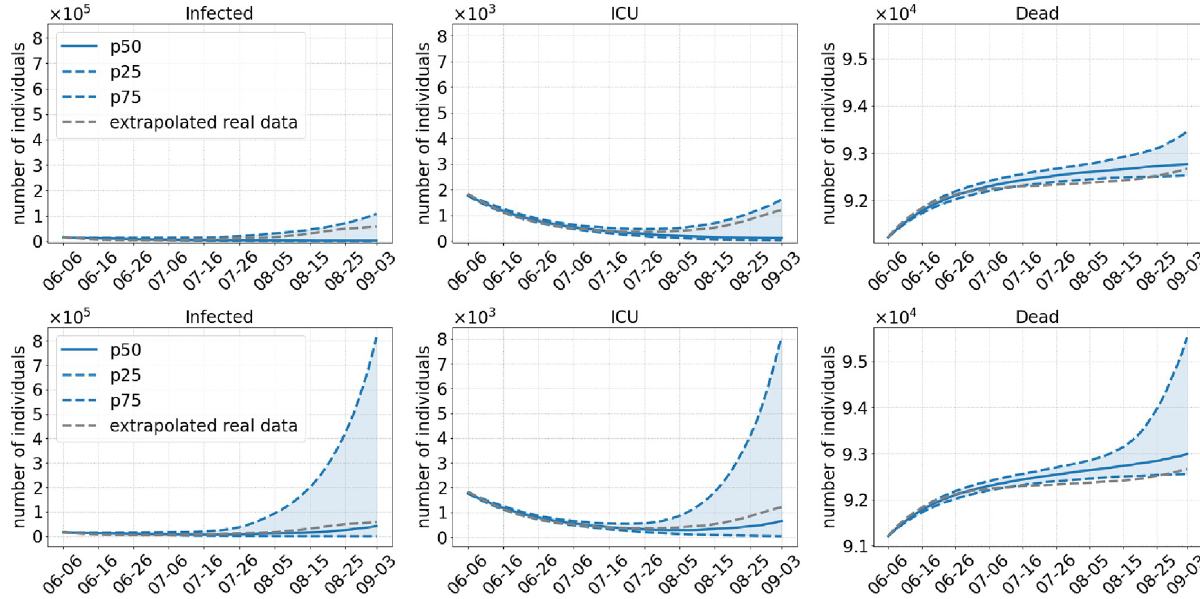
Fig 5. Results of Scenario 2: Commuter testing once a week with local NPIs decreed until July 01, 2021, keeping masks and distancing after opening. The median of 500 runs is shown in solid blue; the blue dotted lines are the 25% and 75% percentiles. The top row shows results with an assumed 40% more transmissible Delta variant compared to 60% in the bottom row.